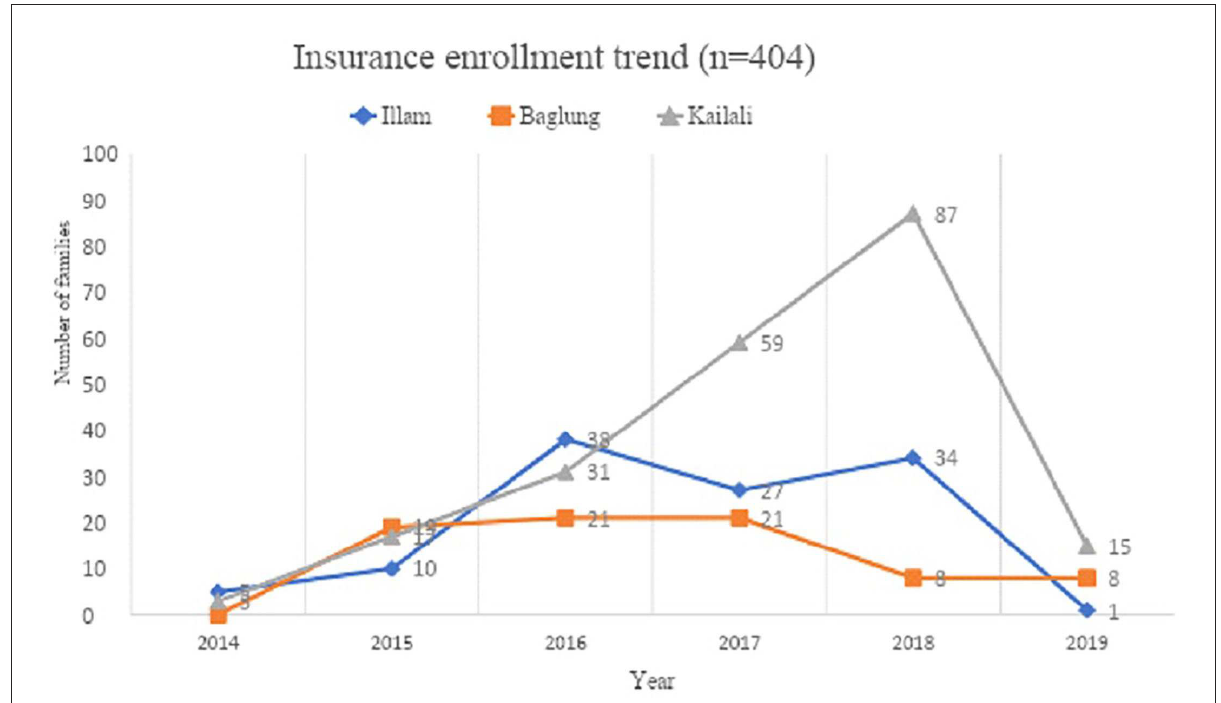
FIGURE2 Trend showing year-wise enrollment of insureds in three districts (Pearson Chi-squared (df), 34.29 (4); p < 0.001; Chi-squared for slope (df), 8.69 (1); p , 0.003; slope, − 0.007; Chi-squared (df) for non-linearity; 25.59 (3), p < 0.001; After removing 2019 data, Chi-squared (df) for non-linearity; 23.66 (2), p <